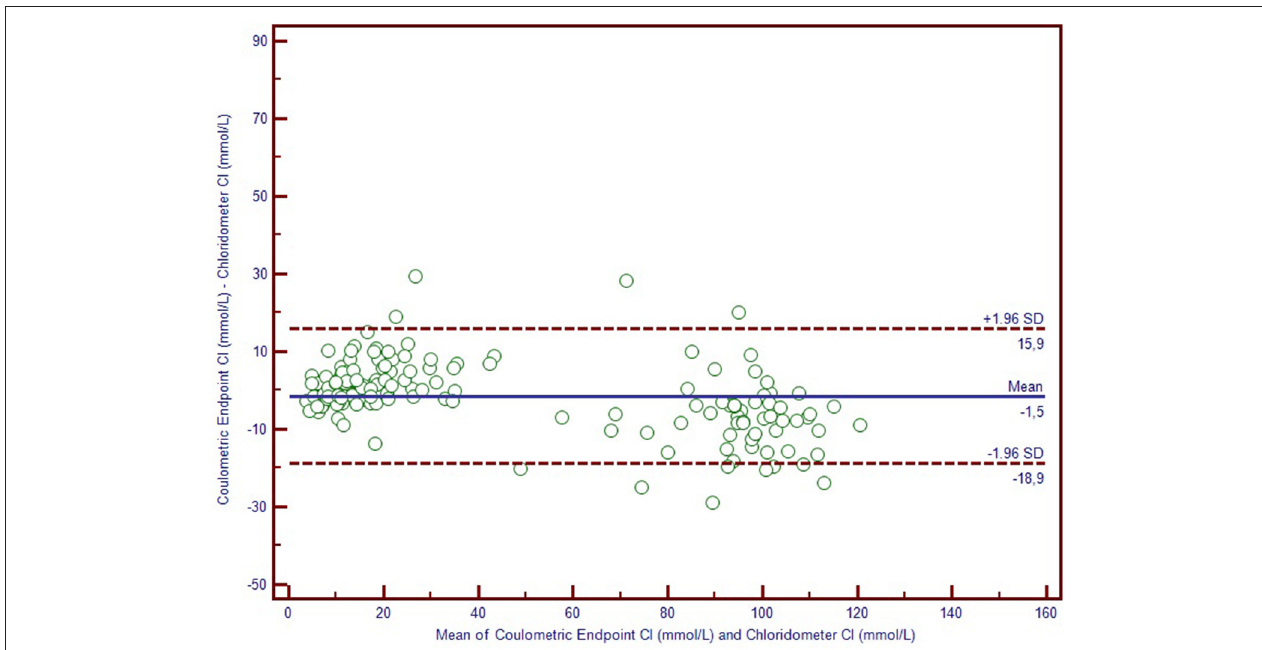
FIGURE 4 | Bland-Altman Plot of chloridometer vs. coulometric endpoint method.